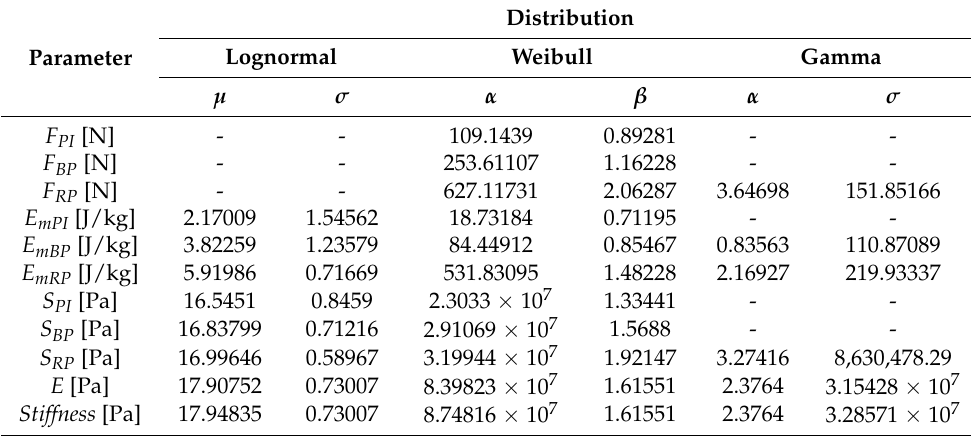
Table A2. Coefficient of R 2 determination of cumulated Weibull, gamma, and lognormal distributions.